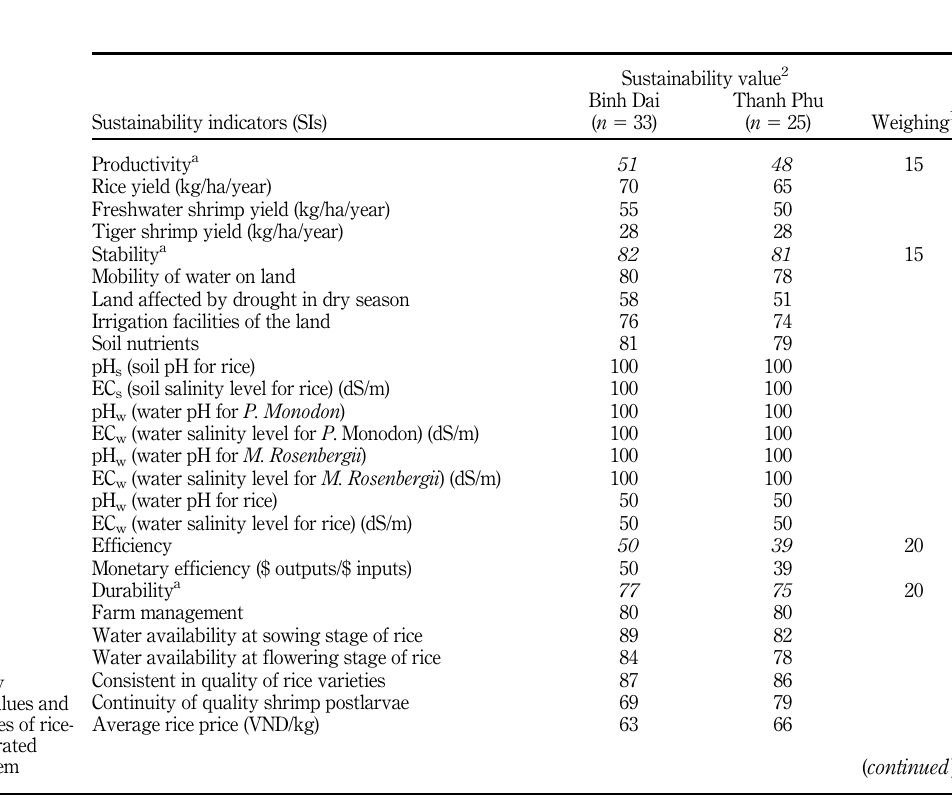
indicators ’ values and overall indexes of rice- shrimp integrated farming